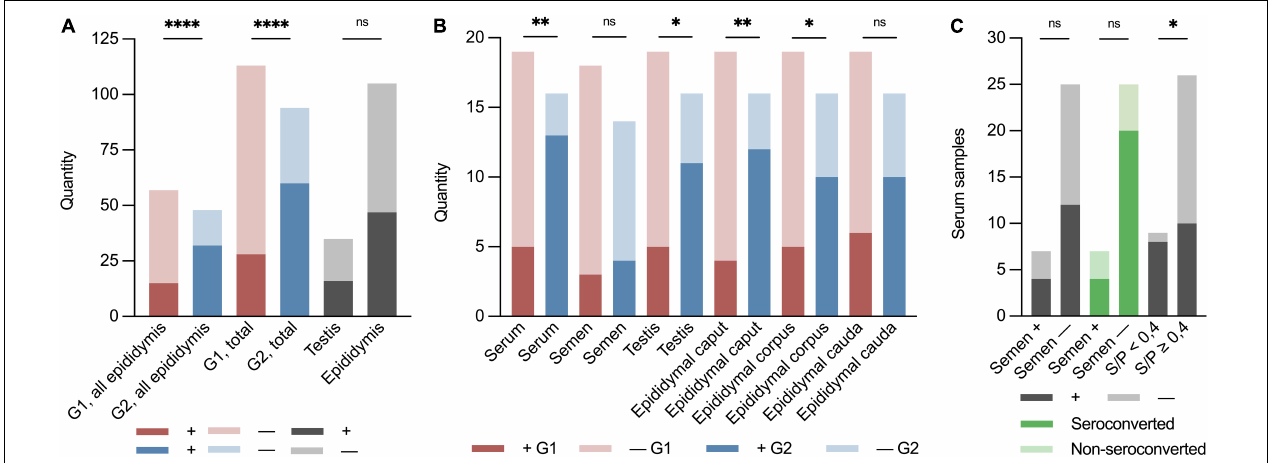
FIGURE 2 | Binary ( ± ) stacked bar plots of sample material from the PRRSV-1-infected boars at the boar stud in Denmark 2019. “ + ” indicates the presence of PRRSV-1 RNA, and “–” indicates not detected by RT-PCR. Red indicates early infected boars, G1; blue indicates later infected boars, G2; and dark grey indicates positive samples in total of testis, epididymis, semen, and serum. Light grey indicates negative samples. Dark green indicates seroconverted boars and light green indicates non-seroconverted boars. (A) Groupwise division of all epididymal samples in G1 and G2 ( p < 0.0001; RR 2.53; 95% CI 1.61–4.15), early (G1) and late (G2) seroconversion of results in RT-PCR of all sample material ( p < 0.0001; RR 2.58; 95% CI 1.83–3.70), and of all testis and epididymis samples ( p = 0.92). (B) Groupwise division of PRRSV-1-viraemic and negative boars at slaughter ( p < 0.01; RR 3.09; CI 1.53–7.06), PRRSV-1-infected and negative semen ( p = 0.67), PRRSV-1-positive and negative testis ( p < 0.05; RR 2.61; 95% CI 1.22–6.11), epididymal caput ( p < 0.01; RR 3.56; CI 1.57–9.10), corpus ( p < 0.05; RR 2.38; CI 1.08–5.64), and cauda ( p = 0.09). (C) Quantity of serum samples on the Y -axis. X -axis shows semen PRRSV-1-positive (+) or PRRSV-1-negative (–) (viraemic: p > 0.99 and seroconverted: p = 0.22), non-seroconverted (S/P < 0.4), and seroconverted boars (S/P ≥ 0.4) ( p < 0.05; RR 2.30; 95% CI 1.28–4.07). Asterisks and “ns” indicate p -value summary ( ∗ p < 0.05, ∗∗ p < 0.01, and ∗∗∗∗ p < 0.0001).